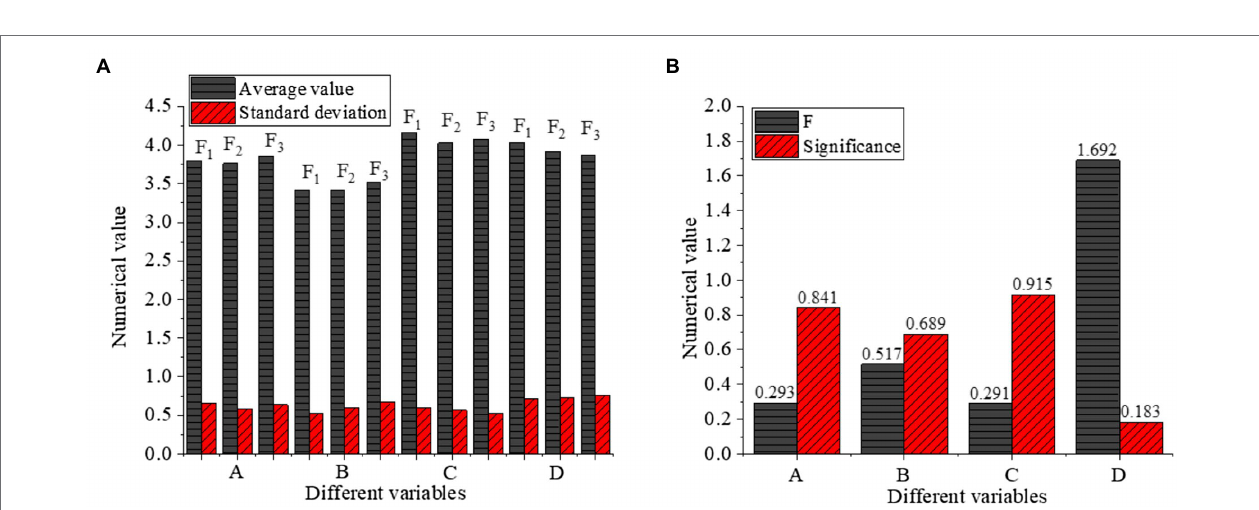
FIGURE 9 | One-way ANOVA of the length of service ( A : different variables with Numerical value, B : different variables with Numerical value, C1: Below one-year, C2: 1–5 years, C3: 5–10 years, C4: 10–20 years, A: Cross-cultural competence, B: Cross-cultural adaptation, C: Entrepreneurial intention, D: Psychological adaptation of venture entrepreneurs * p <